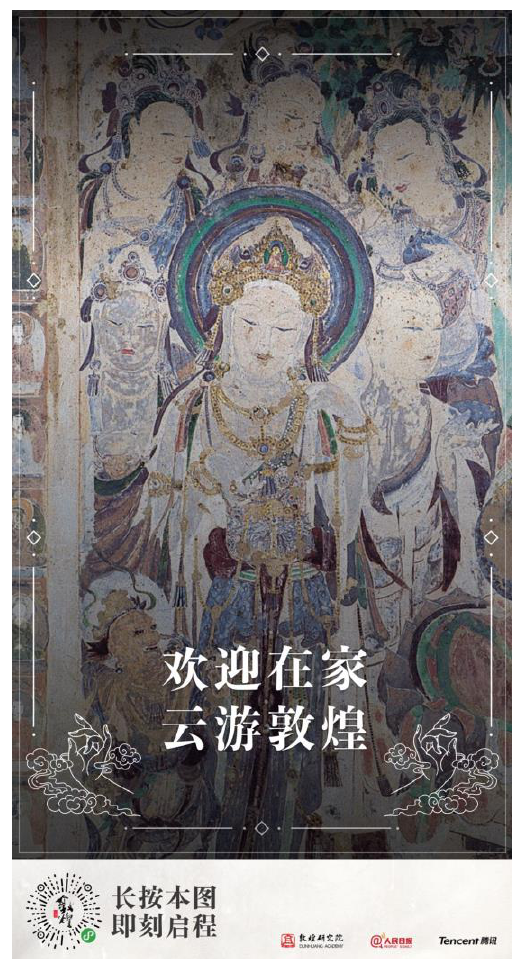
Figure 2 . Cloud Tour of Dunhuang.